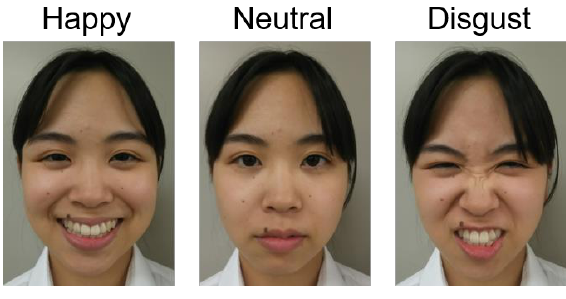
Figure 2. Emotional facial expressions.